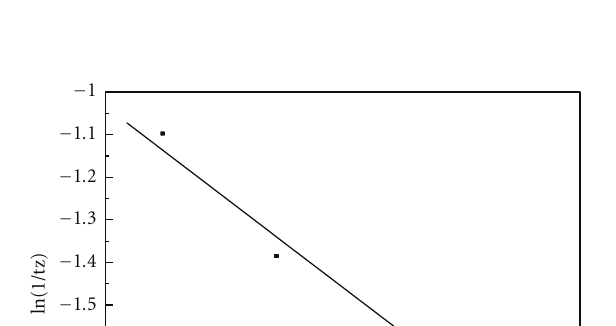
Figure 9: The curve of ln(1/ tu ) versus 1/ T.